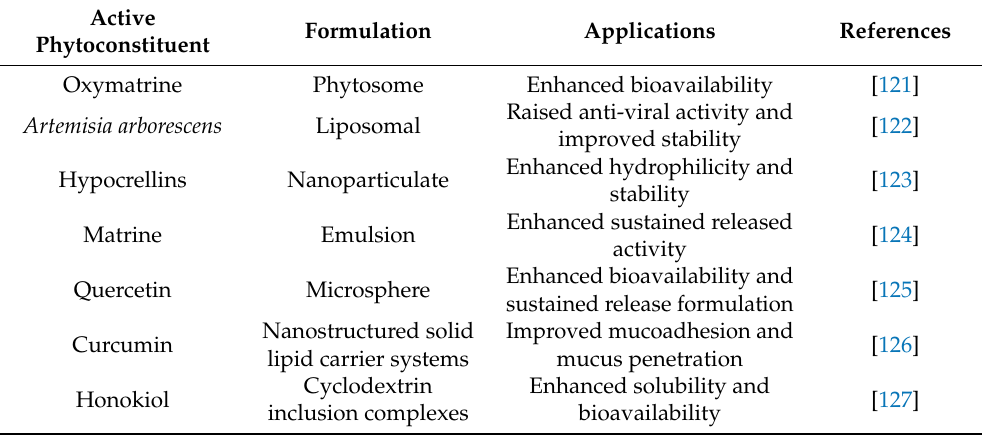
Table 2. Various other formulations contain anti-viral